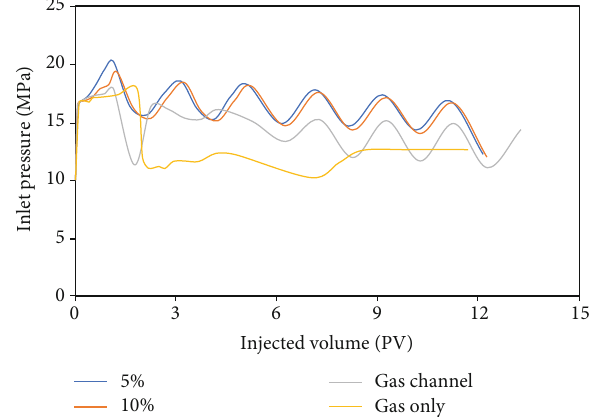
Figure 8: Curve of the relationship between injection volume of alternating gas-water fl ooding and injection pressure in di ff erent